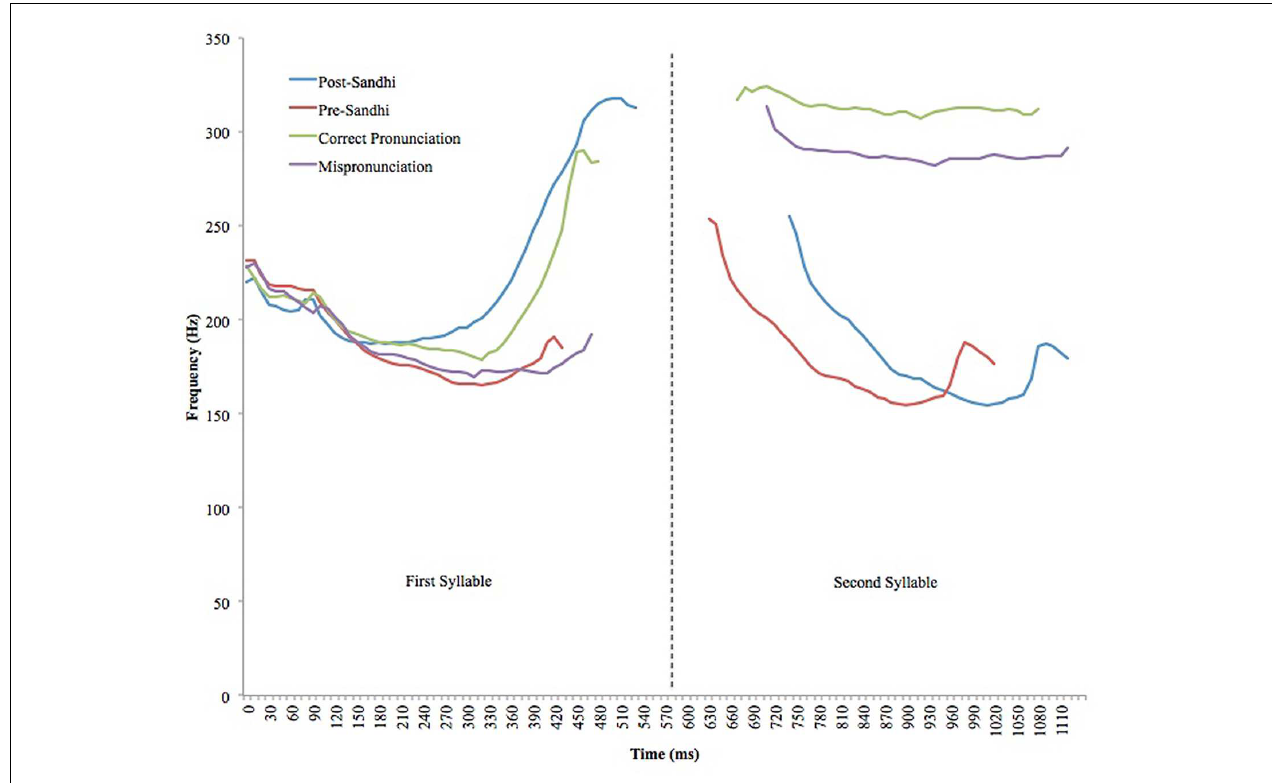
FIGURE 1 | Sample pitch contours of post-Sandhi, pre-Sandhi, correct, and mispronounced